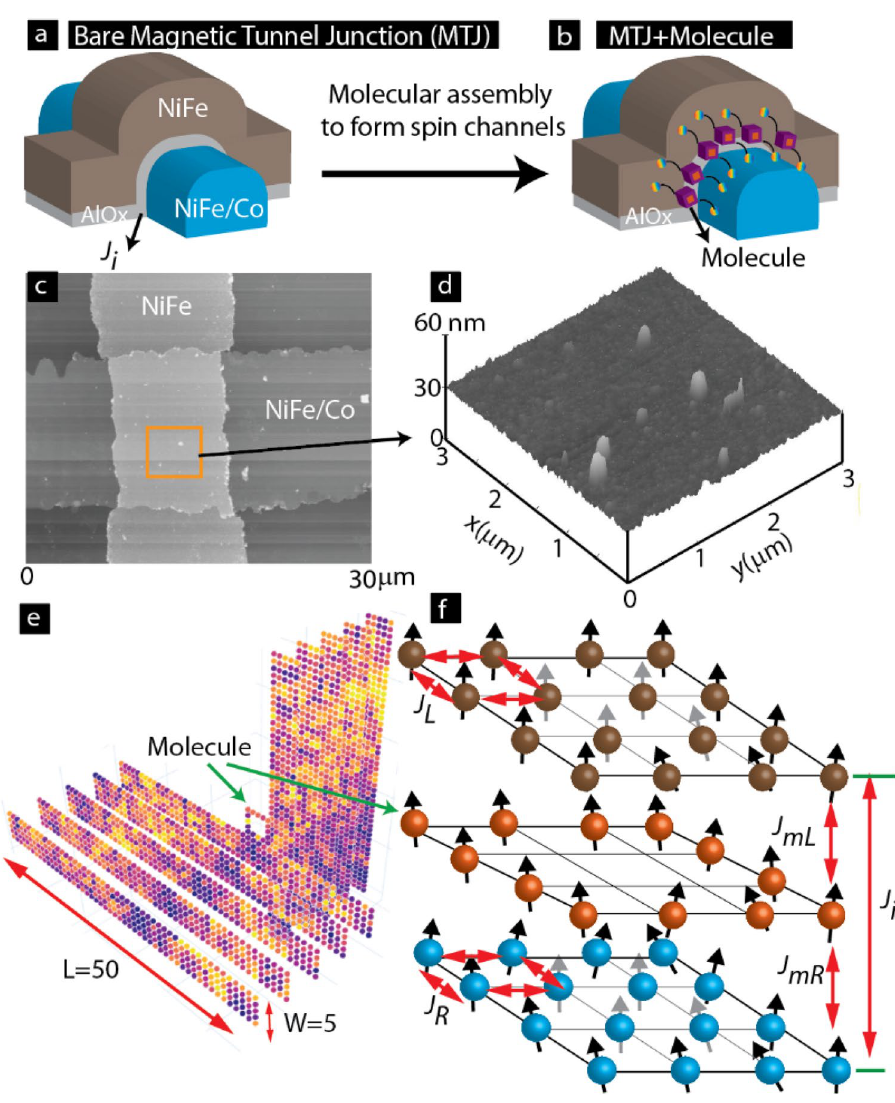
Figure 1. 3D sketch of MTJ ( a ) before and ( b ) after connecting molecules between ferromagnets. AFM image of ( c ) an MTJ testbed with ( d ) hillocks like defects within junction area. ( e ) 3D Heisenberg atomic model of molecular device analogous to MTJMSD shown in panel ( b ). ( f ) Description of different coupling energy around the molecular junction and within ferromagnets of 3D model shown in panel ( e ). Sketches in panel ( a ), ( b ) and ( f ) are prepared in Adobe Illustrator CS6. Images ( c ) and ( d ) are obtained from Atomic Force Microscope. Sketch of 3D cartoon in ( e ) was produced from the indigenously written Python code https:// colab. resea rch. google. com/ drive/ 1ACob 9eSsK m3oH4y_ X43rj LtVnf ockUTv? usp= shari ng. All the components were assembled in Adobe Illustrator CS6 version to produce the composite